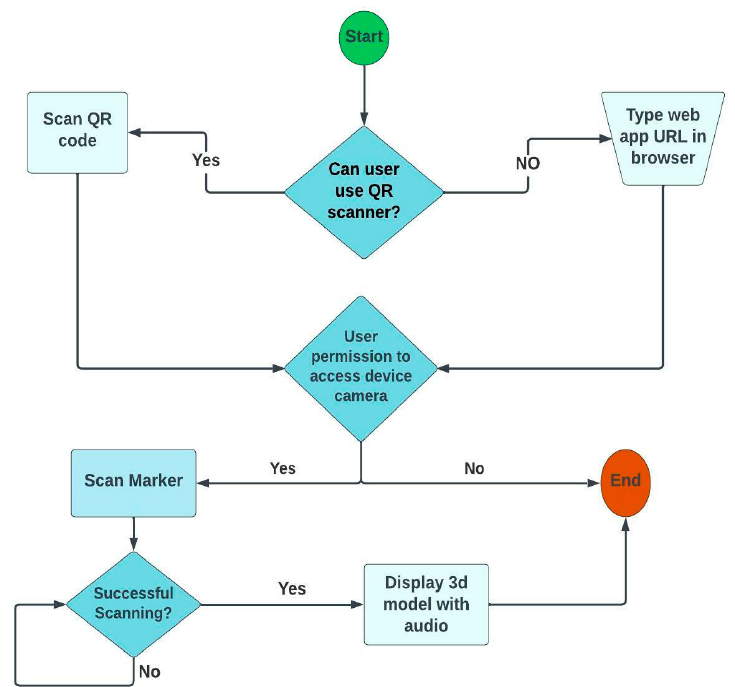
Figure 3. User flow through the proposed Web AR